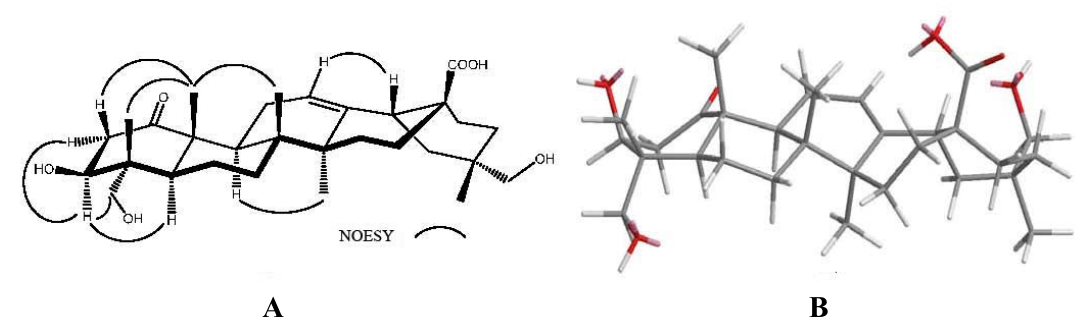
Figure 3. ( A ) Key NOESY (curve) correlations of compound 2 ; ( B ) Computer-generated perspective model of 2 using MM2 force field